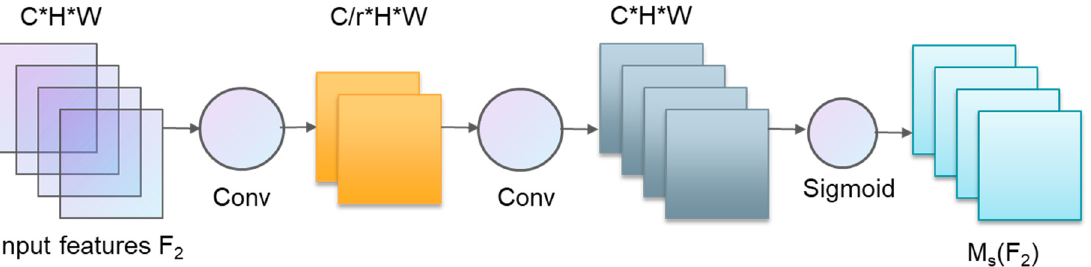
Figure 5. The structure of the spatial attention submodule (average pooling followed by max pooling).